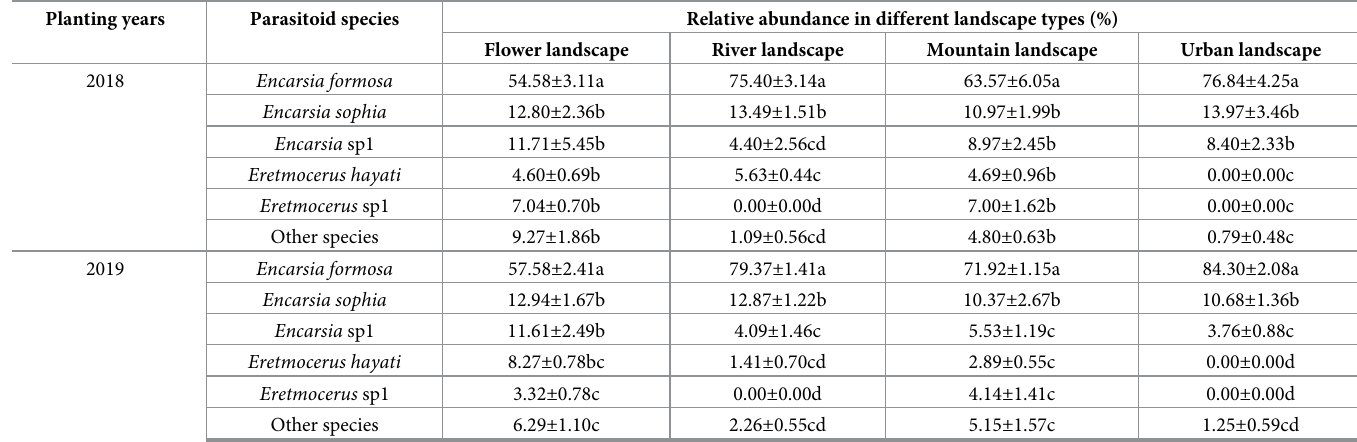
Data in the table are mean ± SE. The different lowercases indicate significantly different at the 0.05 level with the different parasitoid species in the same type of landscapes during the same tomato’s planting